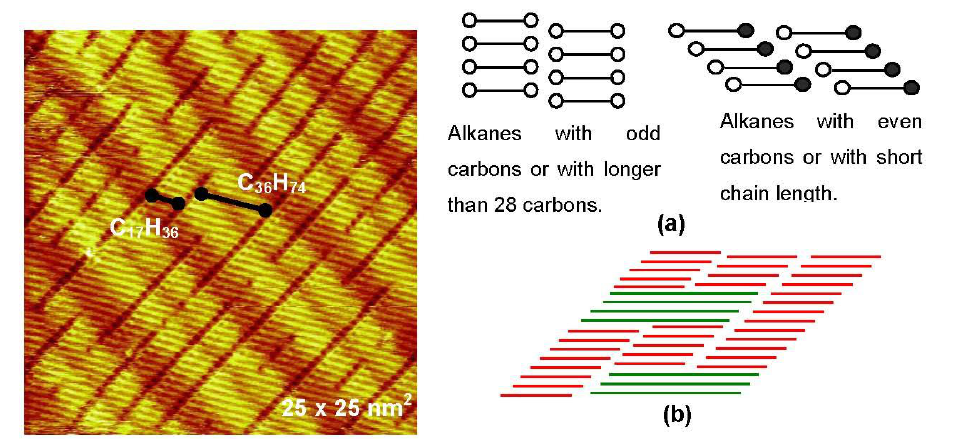
Figure 3. Two dimensional eutectic nano-crystal phase of n -C on a reconstructed Au(111) surface formed in a saturated solution of n -C [13]; ( a ) Models of the array of odd and even carbon alkanes by forming either perpendicular or tilted domain boundary to the molecular axis; ( b ) A model of an eutectic phase of two alkanes with twice different chain